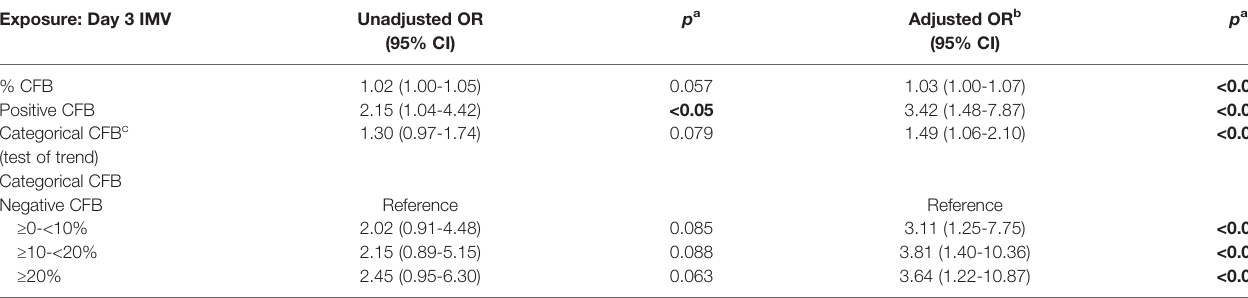
TABLE 2 | Association between day 3 cumulative fl uid balance and PICU mortality. Exposure: Day 3